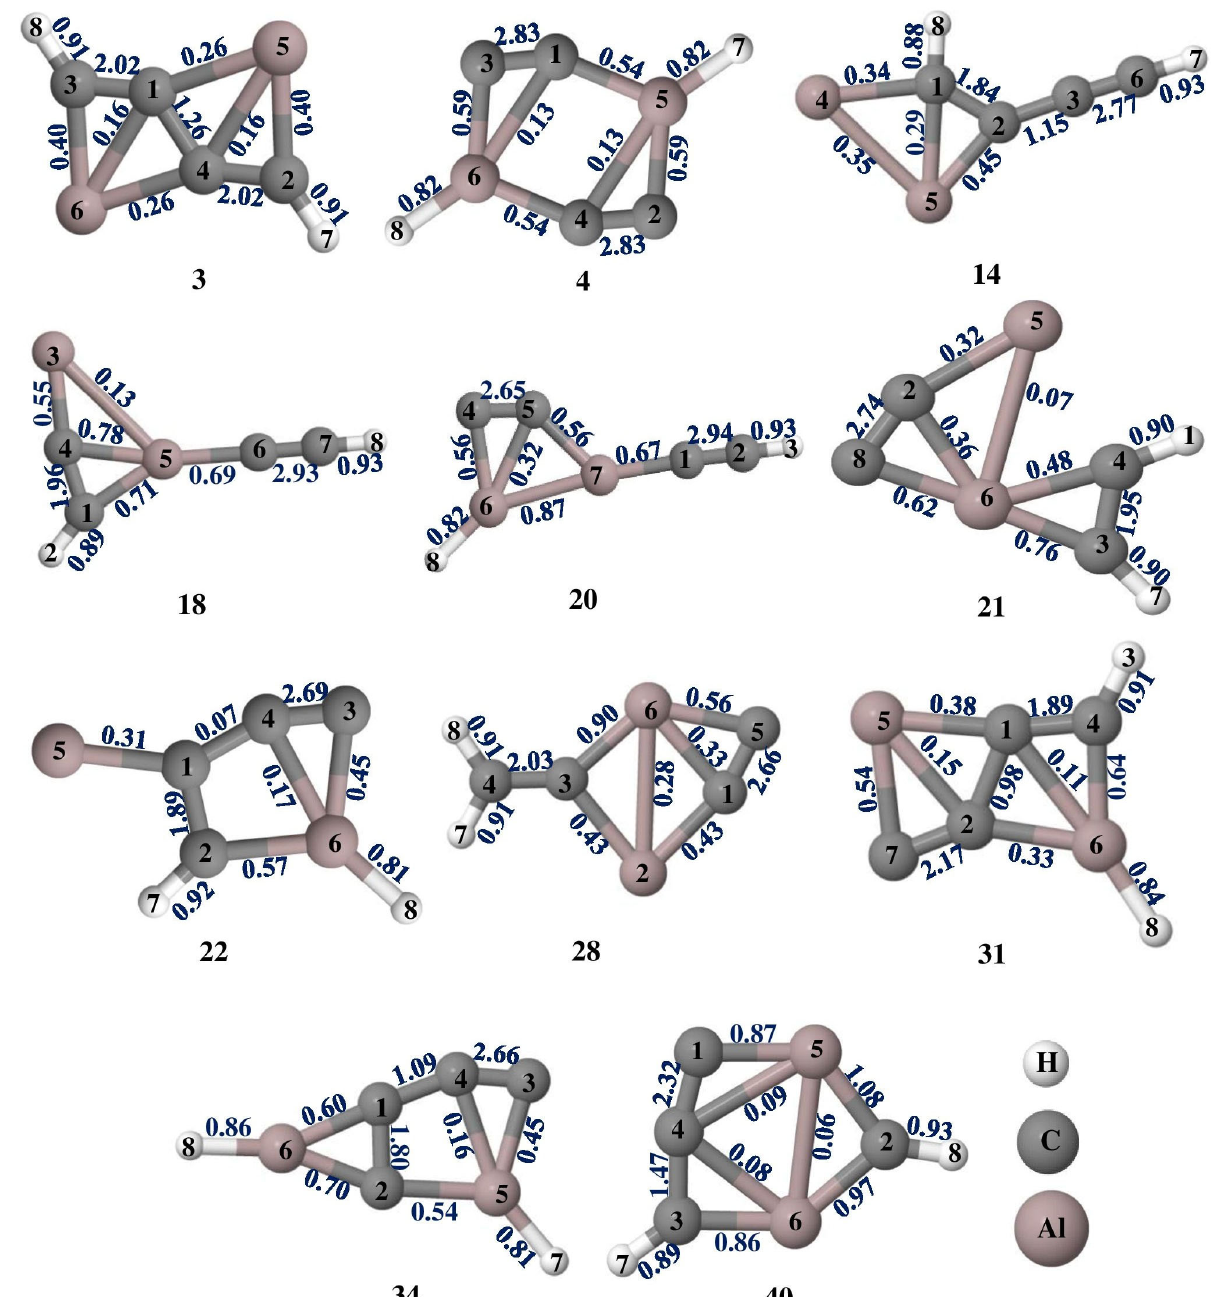
Figure 3. Wiberg bond indices of Al 2 C 4 H 2 isomers 3 , 4 , 14 , 18 , 20 , 21 , 22 , 28 , 31 , 34 , and 40 at the ω B97XD/6 ‐ 311++G(2d,2p) level of